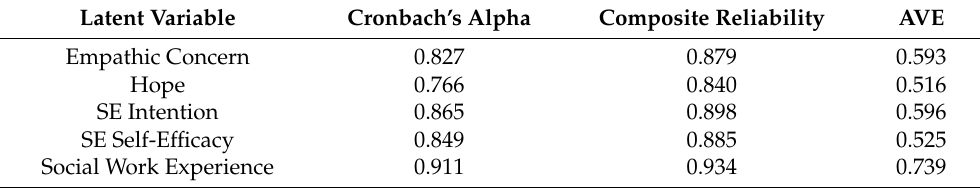
Table 3. Construct Reliability and Validity.